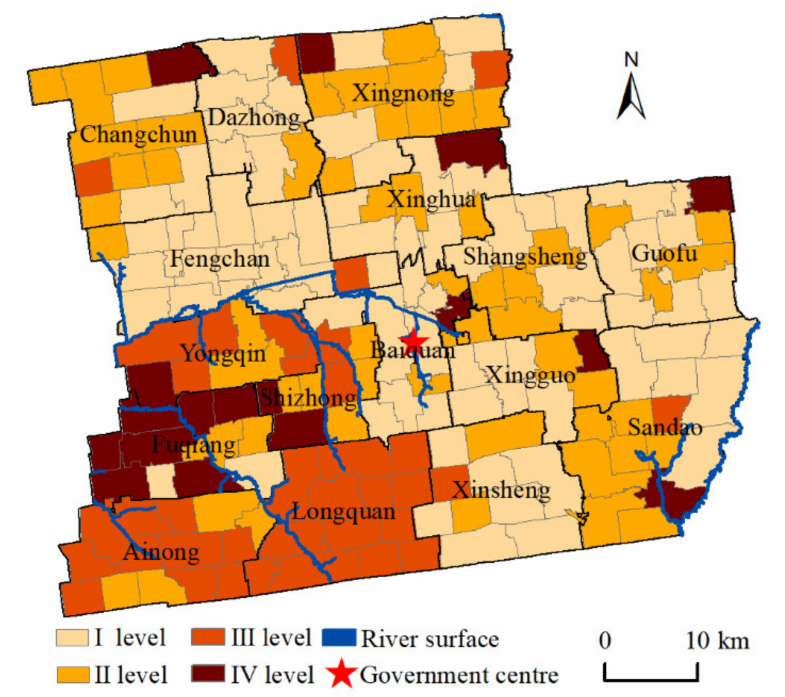
Figure 7. Distribution of the land structure of cultivated land